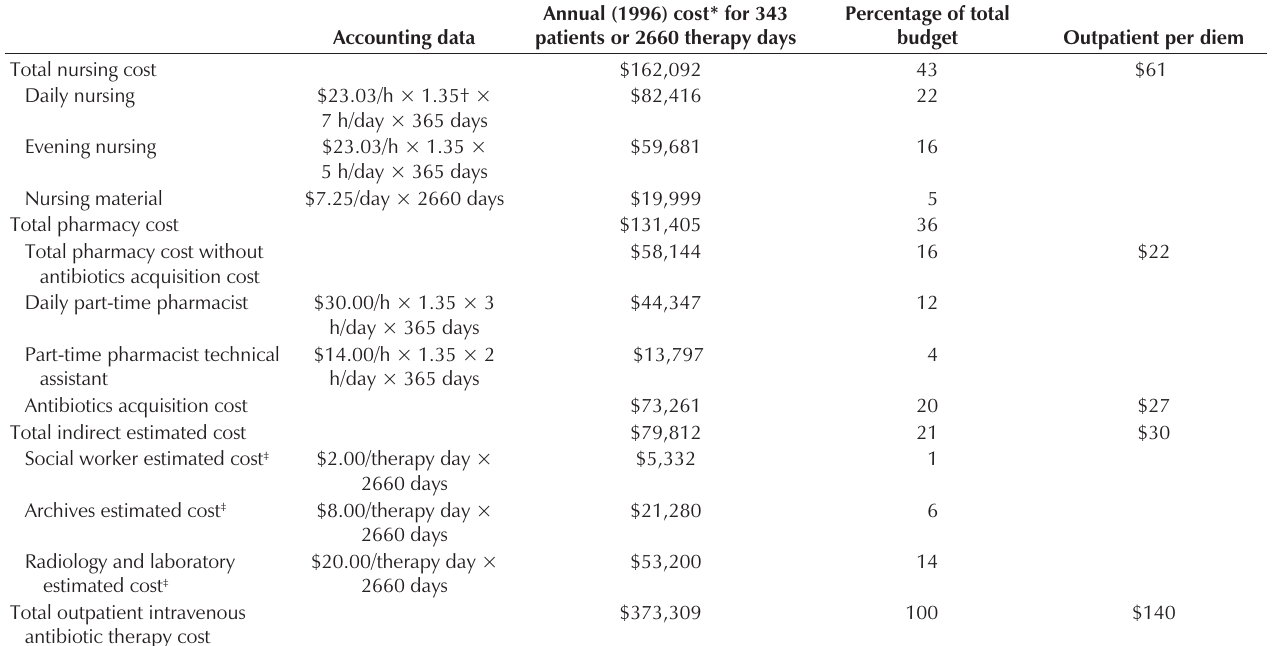
Cumulative cost for outpatient intravenous antibiotic therapy at Hôpital Charles Lemoyne (January 1, 1996 to December 31,